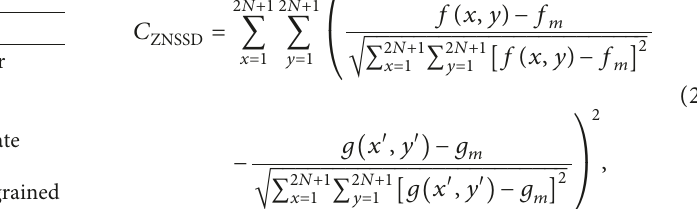
Table 1: Detailed information of the tested